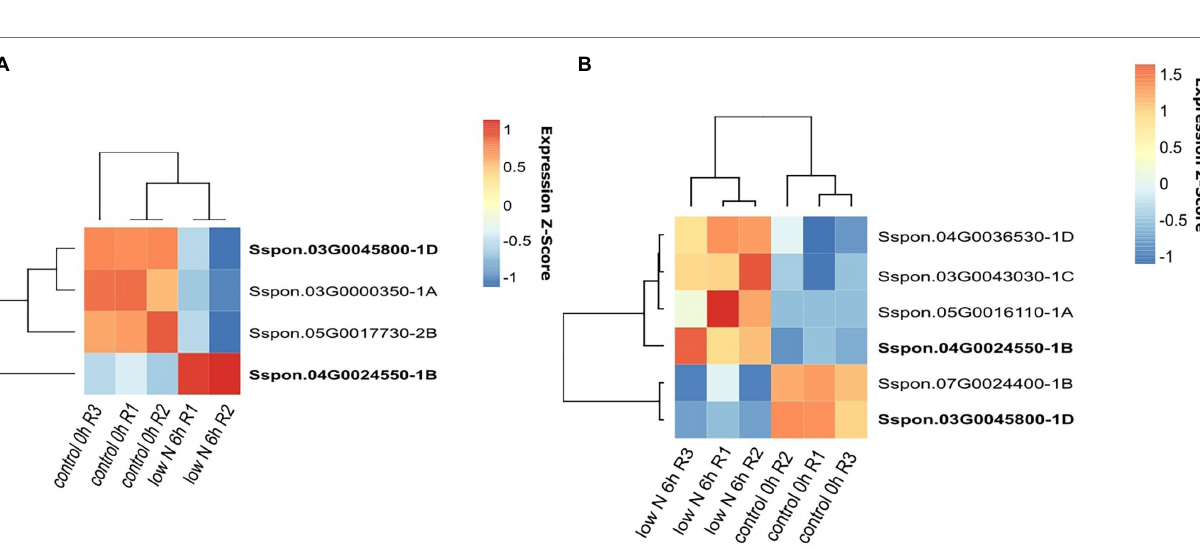
FIGURE 5 | Genes differentially expressed (DE) under low-nitrogen conditions. RNA samples were extracted from leaves of the ROC22 (A) and Badila (B)